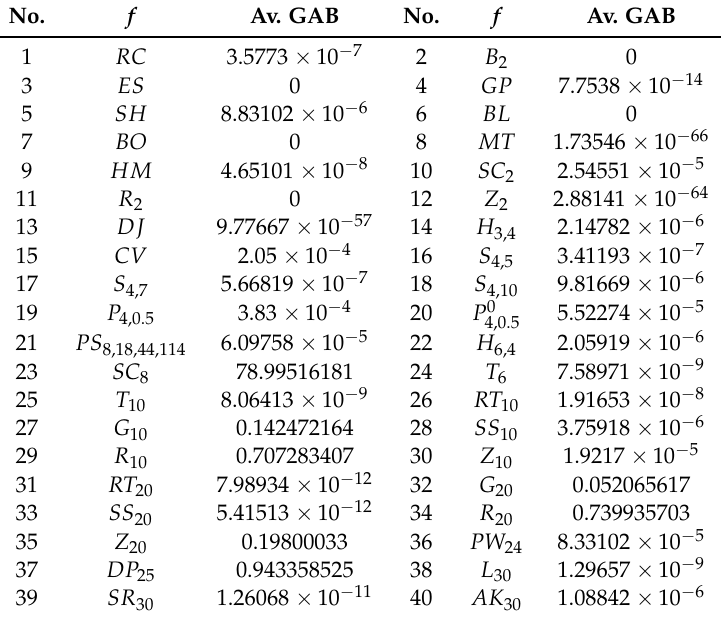
Table 7. DSS results on Set B.